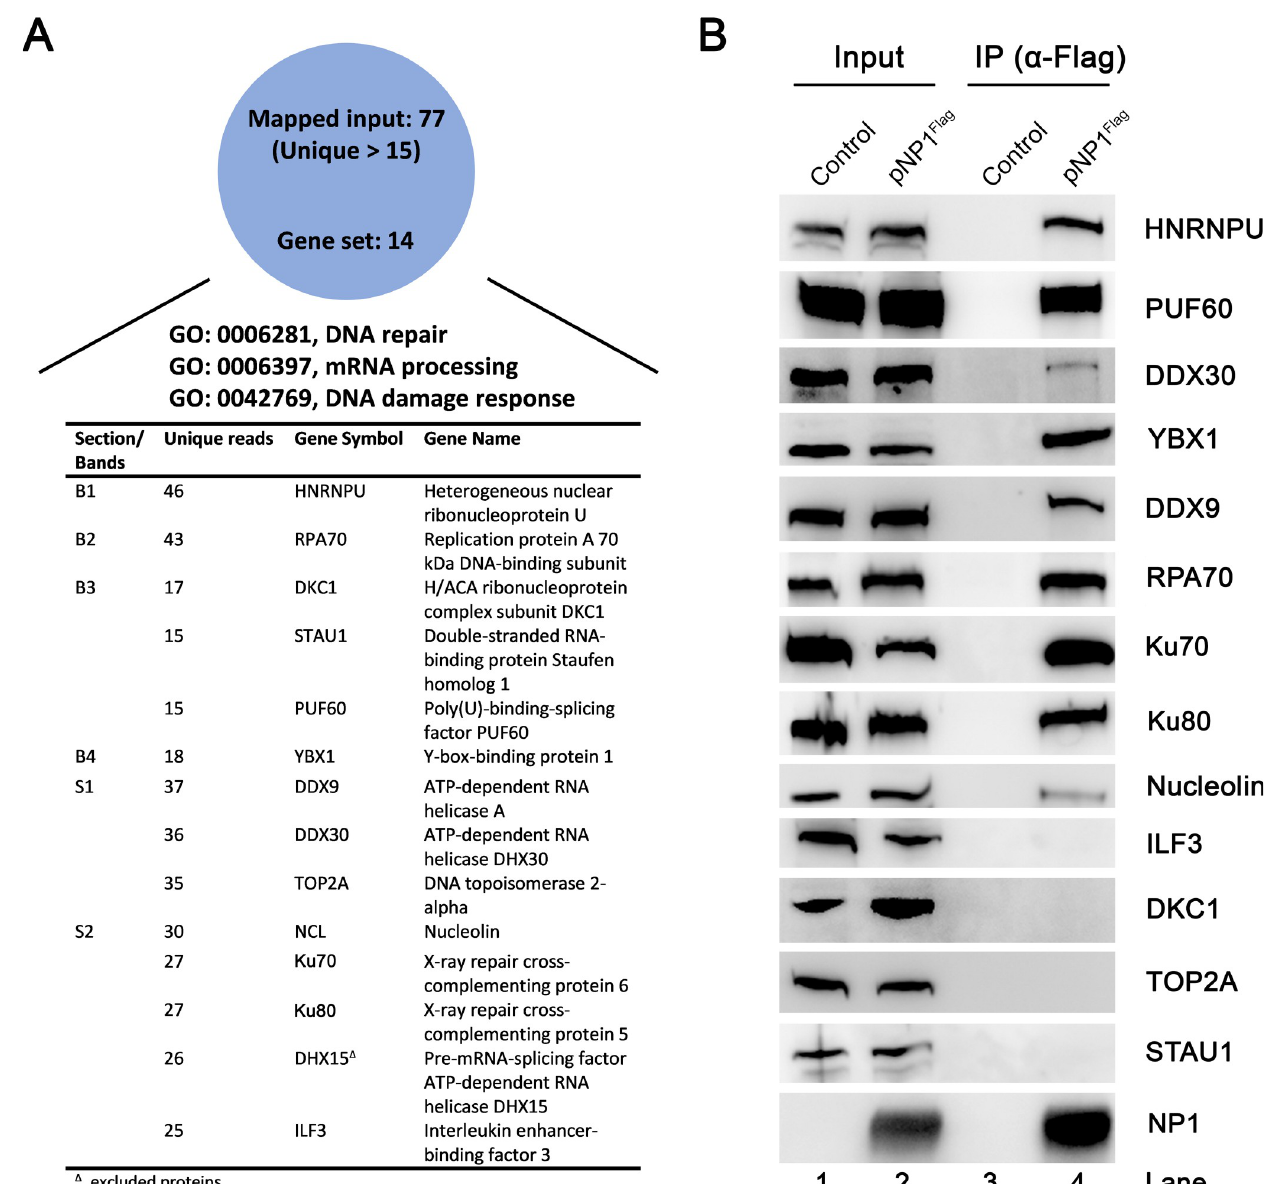
Fig 2. Confirmation of HBoV1 NP1-interacting proteins using co-immunoprecipitation (Co-IP) assay. HEK293 cells were transfected with pCI-NP1 Flag or pCI (as a vector control). At 48 h post-transfection, immunoprecipitation was performed with anti-Flag-conjugated agarose resin using Lysis buffer containing Benzonase, followed by Western blotting. (A) Gene Ontology (GO) analysis. The GO analysis of HBoV1 NP1-interacting proteins with unique peptide reads of over 14 by mass spectrometry (MS) was performed using Metascape (http://metascape.org/) and categorized by their biological processing functions. A summary of key NP1-interacting host proteins that have functions in DNA repair, mRNA processing, and DNA damage response are shown. Proteins identified in each section/band pulled down with anti-Flag (NP1 Flag ) are shown with gene symbols and protein names, respectively. (B) Co-IP. Selected NP1 interacting proteins involved in DNA repair, mRNA processing, and DNA damage response were confirmed by Co-IP assays. Proteins detected by respective antibodies (against the 13 hits in panel A ) are indicated at the right of each image. 10% of the cell lysates were loaded as input controls (lanes